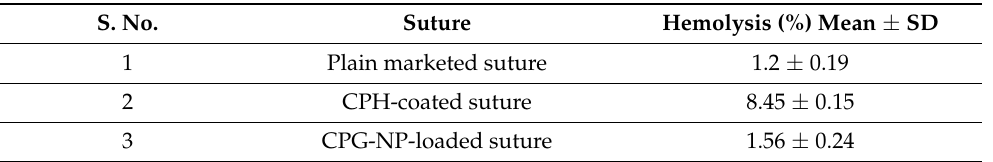
Table 4. Hemolysis of plain marketed suture, plain drug-loaded suture, and CPG-NP loaded suture ( n = 3).